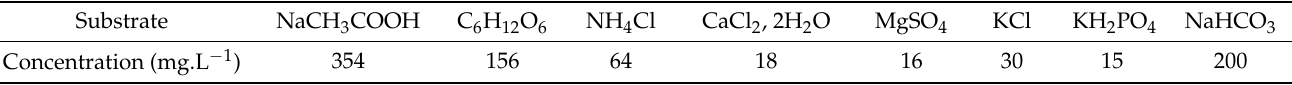
Table 1. Feed wastewater